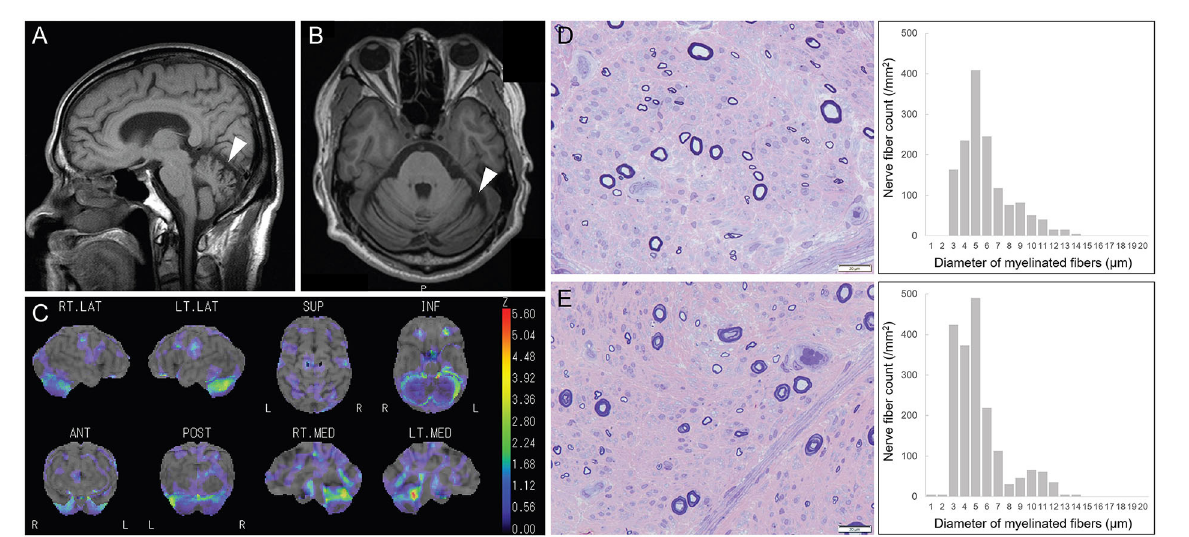
FIGURE3 Radiological and pathological features of patients with disease-associated RFC1 repeat expansions. (A,B) Brain MRI shows cerebellar atrophy (white arrow; P10). (C) Brain single photon emission computed tomography (SPECT) reveals decreased blood flow in the cerebellar region (P21). (D,E) Marked loss of large and small myelinated fibers (large > small). Myelinated fiber densities are 1,456/mm 2 and 1,880/mm 2 , respectively, from P31 with [(AAGGG)exp/(AAGGG)exp] and P10 with